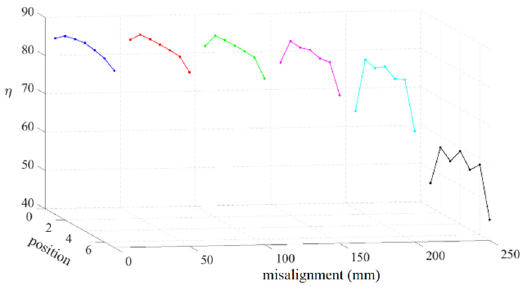
Figure 25. Power transfer efficiency vs pickup misalignment.